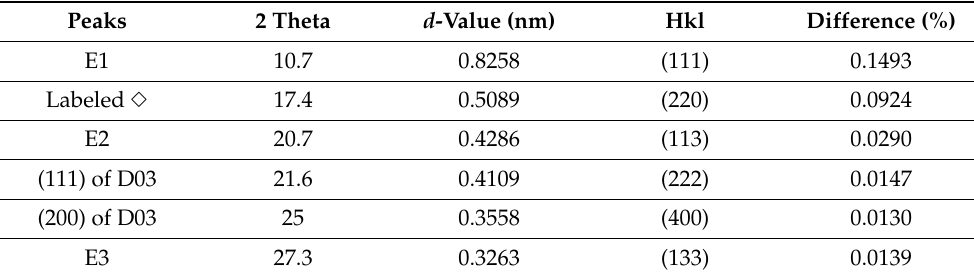
Figure 6. Electron diffraction patterns corresponding to the E phase with twice the lattice constant of D0 3 . Incident electron beams in ( a , b ) are parallel to [510] and [521], respectively. The spots are assigned by the D0 3 structure. Table 2. XRD peaks list corresponding to E phase with a lattice constant of 1.426 nm. The XRD pattern is the alloy annealed at 643 K in Figure 3.